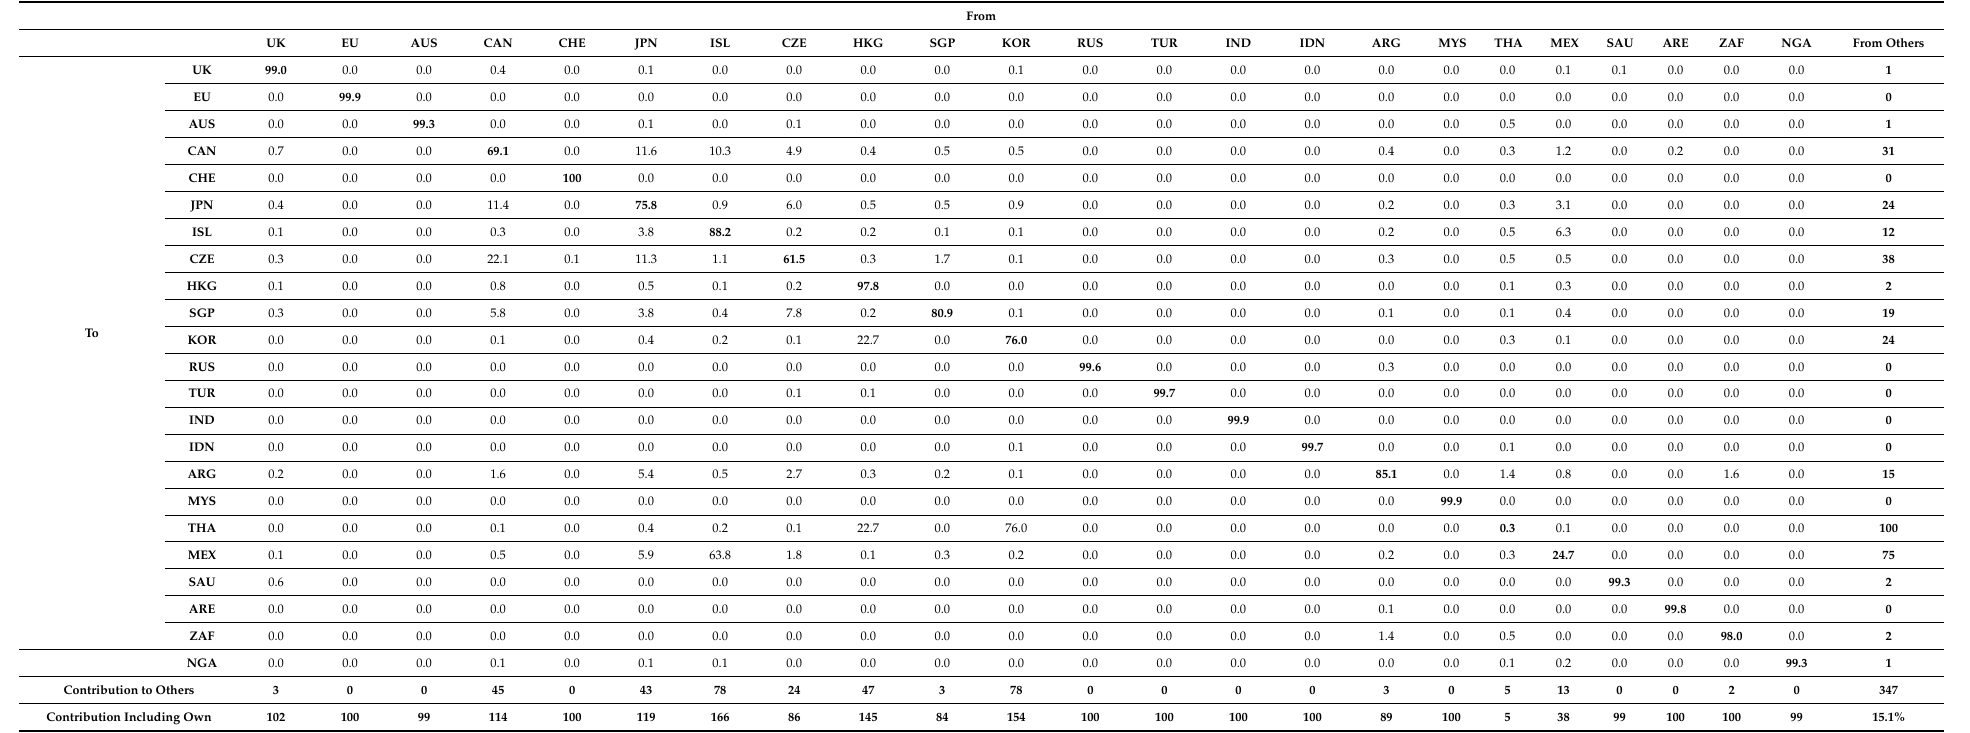
Table 3. Spillover table. Global foreign exchange (FX) market return, 31 May 2005–1 June